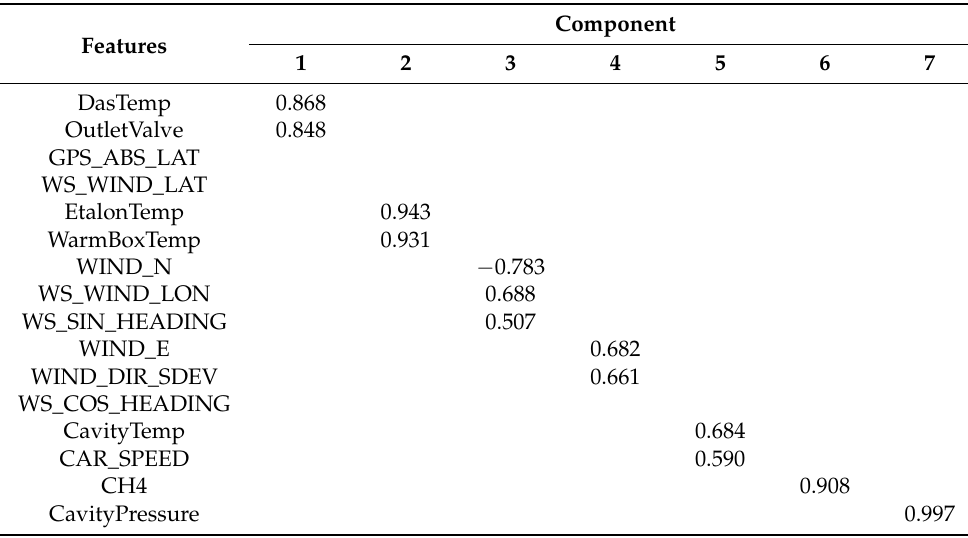
Table 2. Rotated component